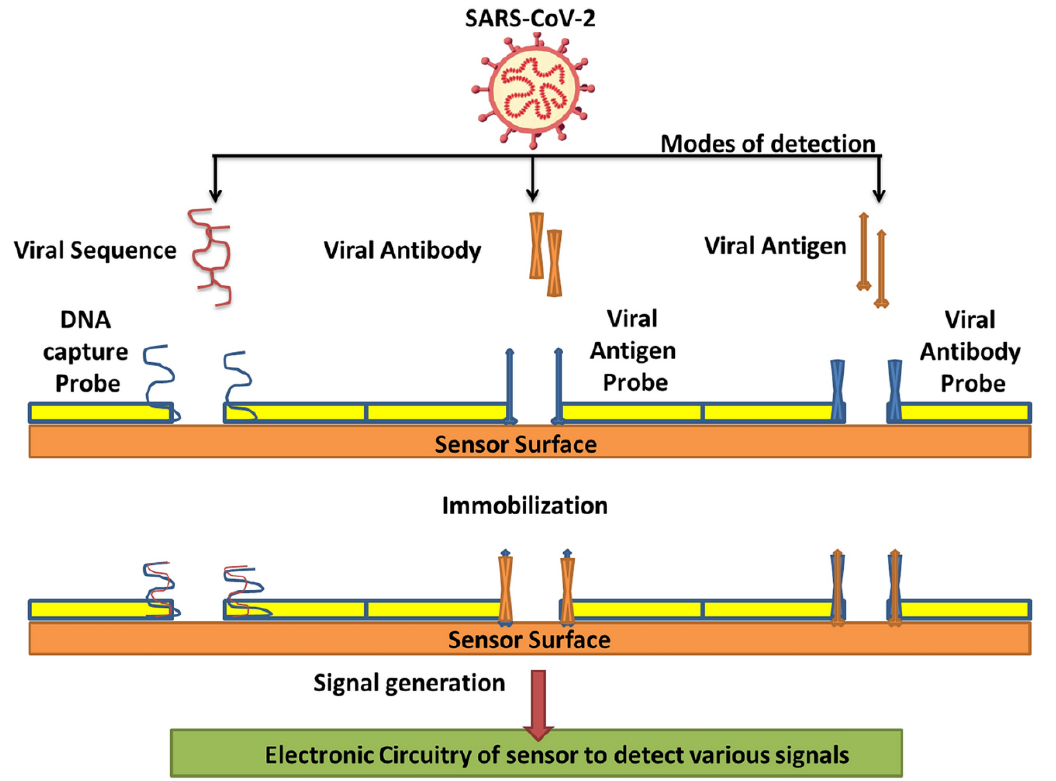
Figure 3. Various modes of detection for SARS-CoV-2 via nanobiosensors (reproduced with permis- sion from V. Chaudhary, et al., Nanotechnol. Environ. Eng. 6 (2021) 8 Table 1. Characteristics of nanobiosensors for detection of SARS-CoV-2 virus.